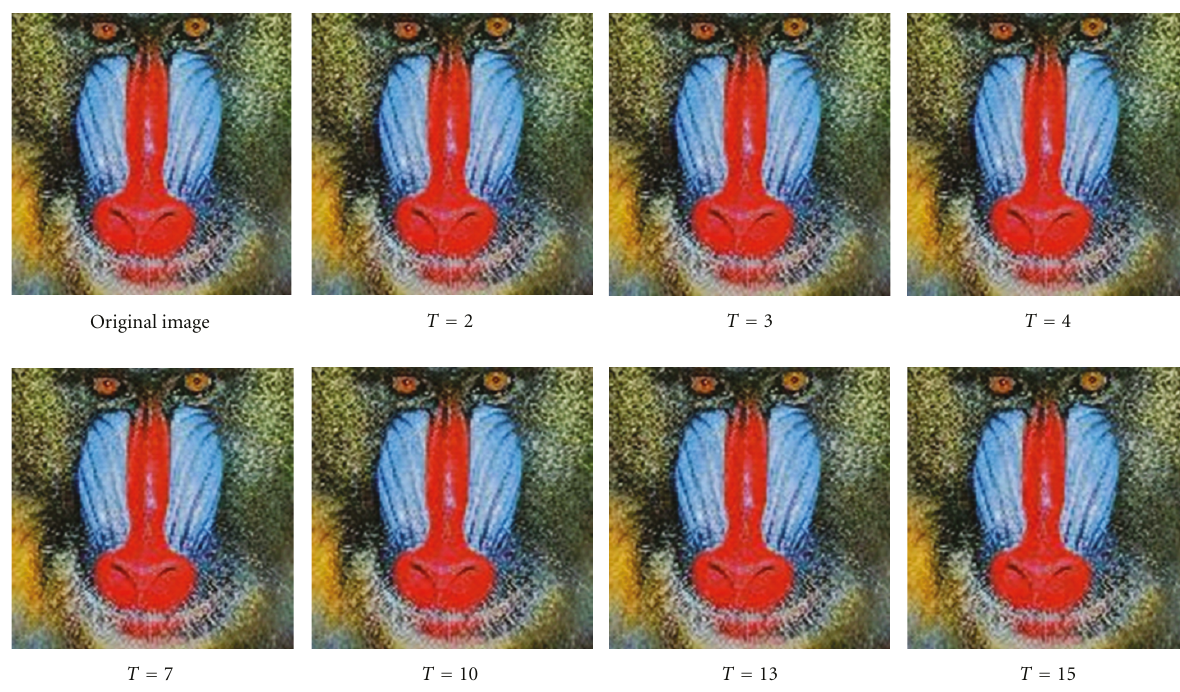
Figure 4: The original Mandrill image and the stego-images with di ff erent distance thresholds.